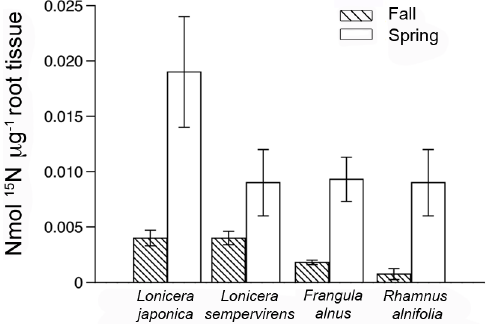
Figure 4. Mean ± SE of 15 N (nmol ug 2 1 root tissue) accumulated in new first and second order fine roots during fall 2011 and spring 2012 at 6 hours of exposure to 1 mmol 15 N exposure. Species are ordered from left to right: L. japonica , L. sempervirens , F. alnus , R. alnifolia .